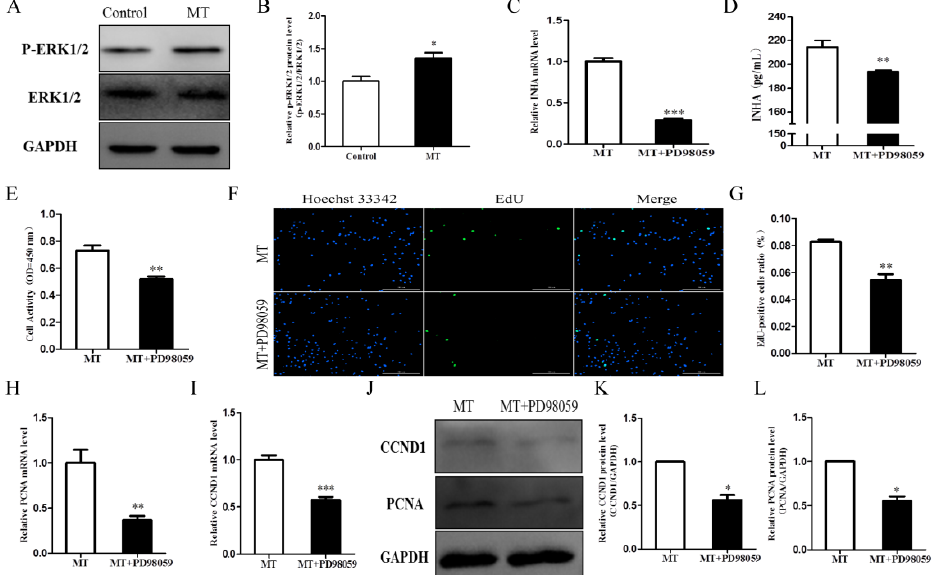
Figure 6. Effects of melatonin and PD98059 on cell proliferation and INHA expression in chicken Sertoli cells. ( A ) The protein level of p-ERK1 / 2 (n = 3). ( B ) Quantitative analyses of the p-ERK protein results. ( C ) INHA mRNA levels of chicken Sertoli cells (n = 3). ( D ) INHA levels of chicken Sertoli cells by ELISA (n = 3). ( E ) Cell viability of chicken Sertoli cells (n = 3). ( F ) The EdU method was used to measure chicken Sertoli cell proliferation ( × 10 magnification; n = 3). ( G ) Statistical analysis of data in ( F ). The relative mRNA expression levels of ( H ) proliferating cell nuclear antigen (PCNA) and ( I ) Cyclin D1 (CCND1; n = 3 for both). ( J ) The relative protein expression levels of CCND1 and PCNA. Quantitative analyses of the ( K ) CCND1 and ( L ) PCNA protein results (n = 3 for both). *** p < 0.001, ** p < 0.01 or * p < 0.05.